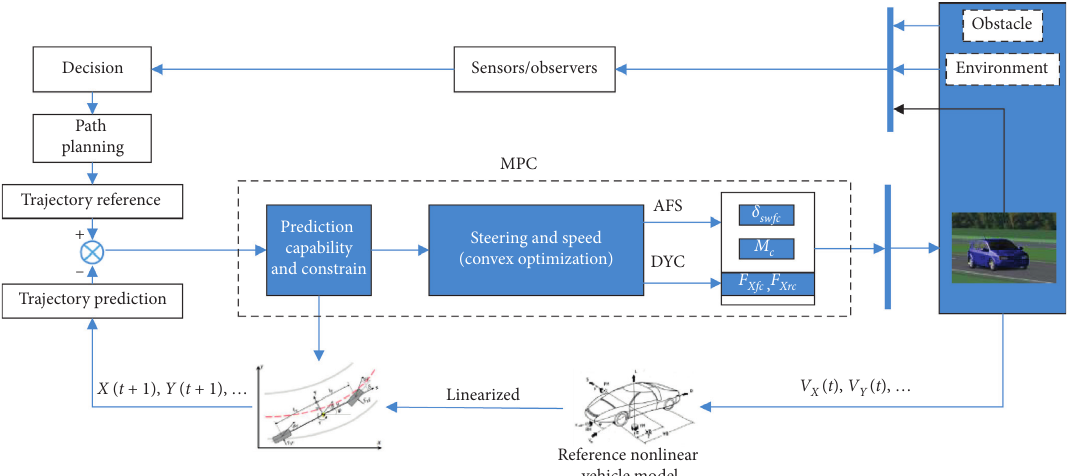
Figure 6: Structure of the safe lane-change intelligent control system.